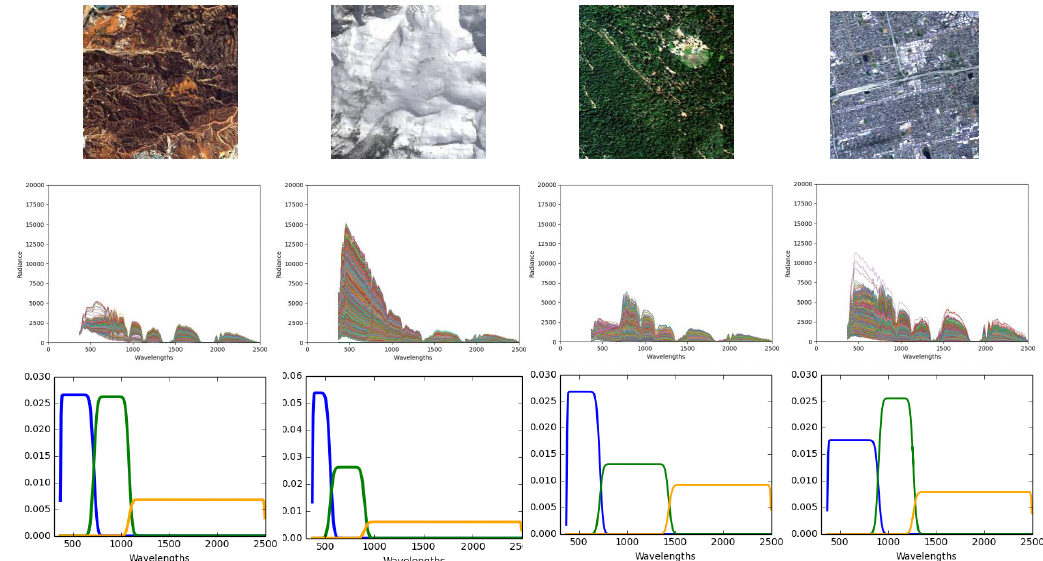
Figure 5. Examples of RGB-display images (form left to right) of Mountain, Snow, Forest, and Dense-Urban categories (line 1) with their corresponding spectra (line 2) and best triplet of SSFs (line